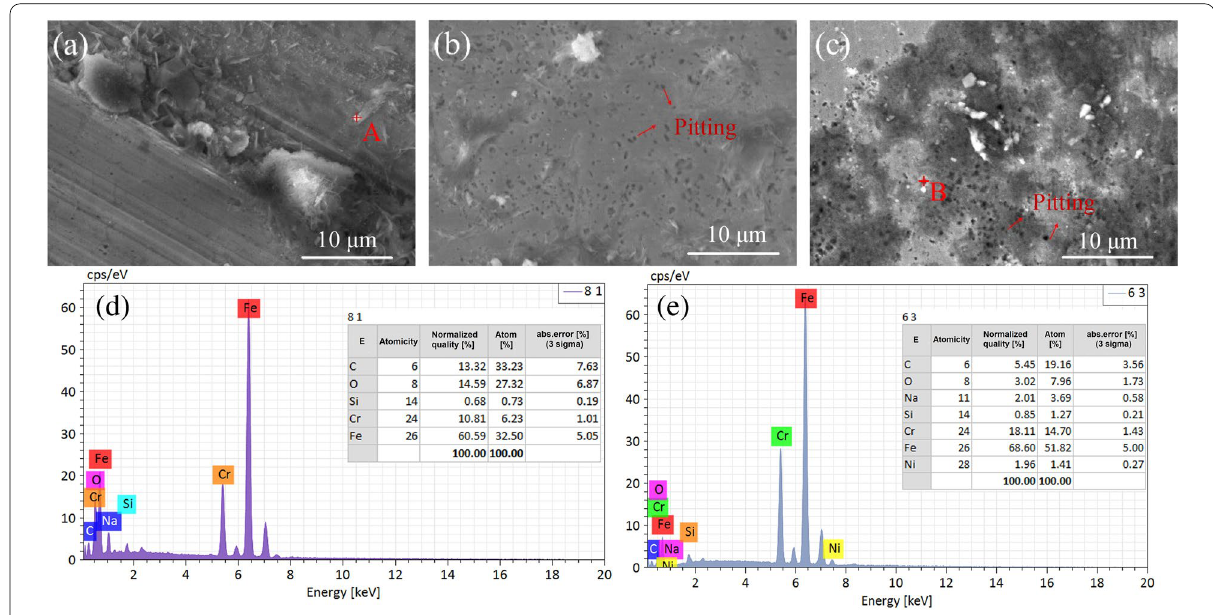
Figure 10 Corrosion morphology of the samples: ( a ) Milled, ( b ) U-rolled, ( c ) T-rolled, Energy spectra at positions ( d ) A and ( e )